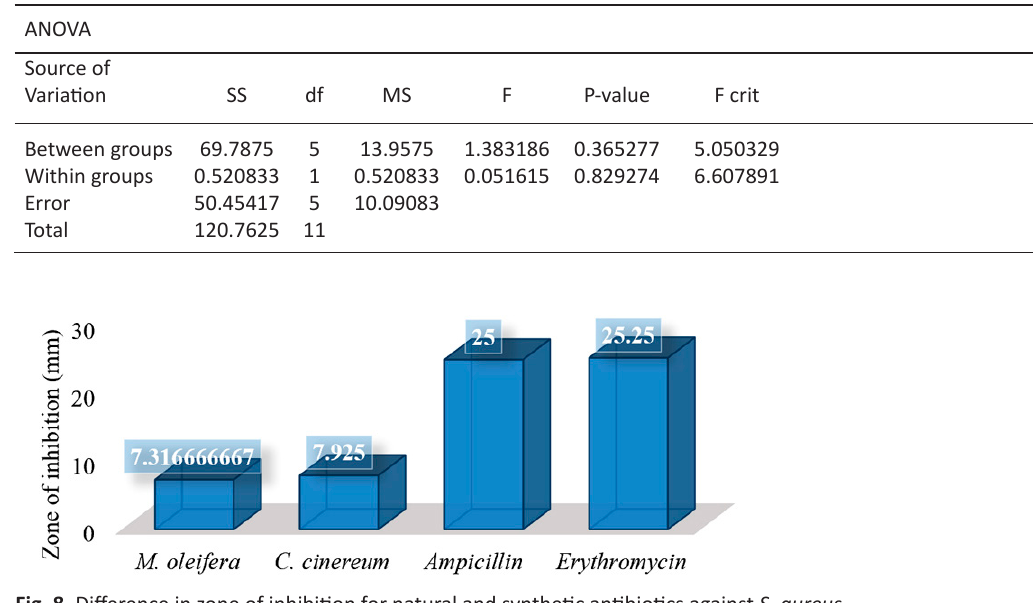
Fig. 8. Difference in zone of inhibition for natural and synthetic antibiotics against S. aureus